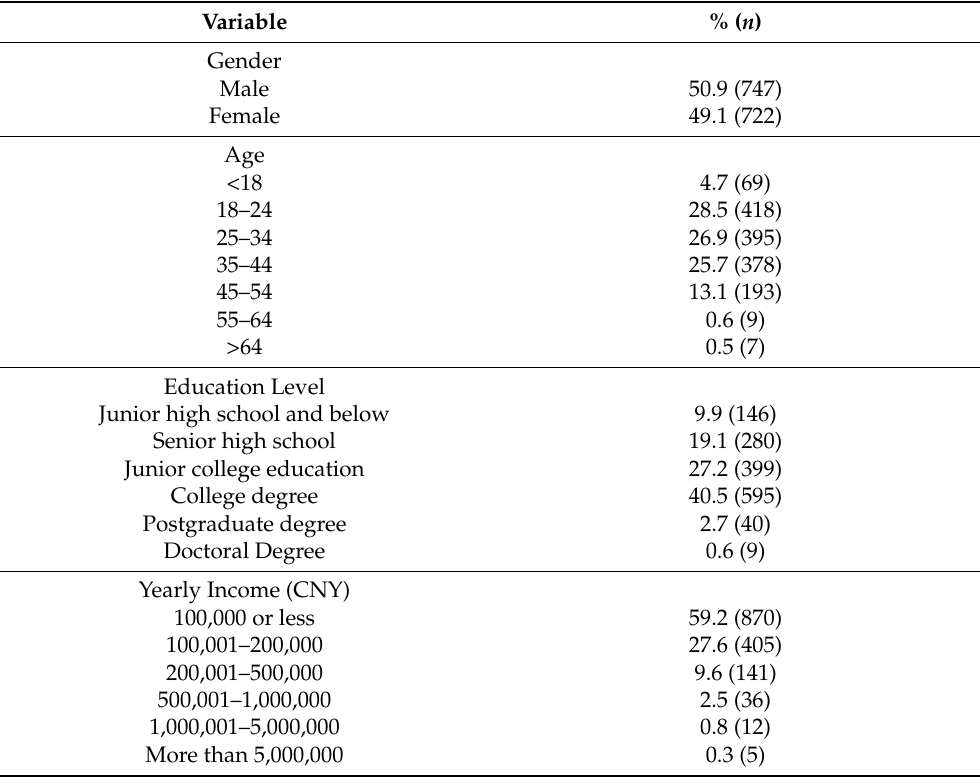
Table 1. Distribution of demographic characteristics of the sample ( n =